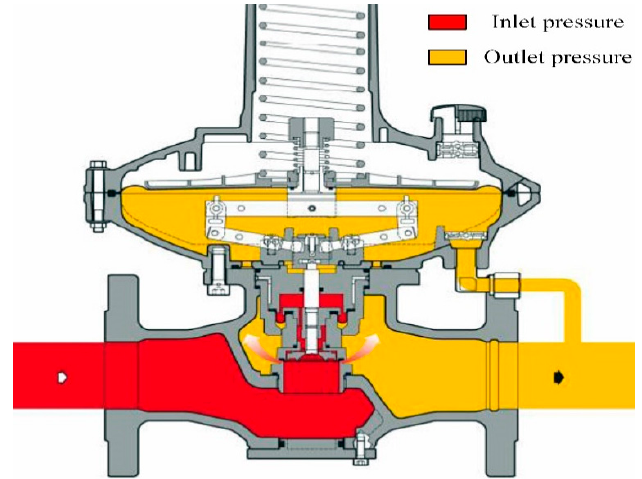
Figure 5. The flow of natural gas in pipelines.